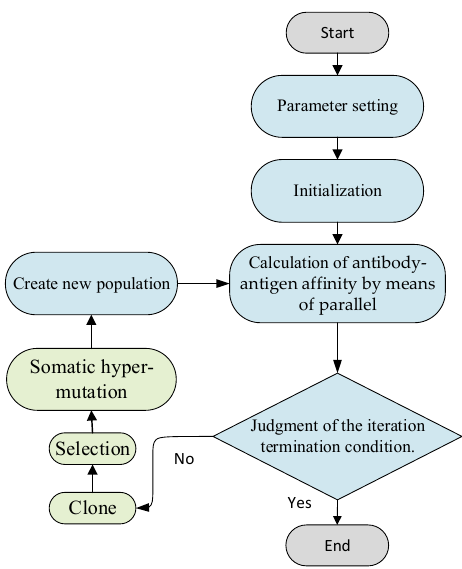
Figure 9. Process of the parallel adaptive clonal selection algorithm (PACSA).